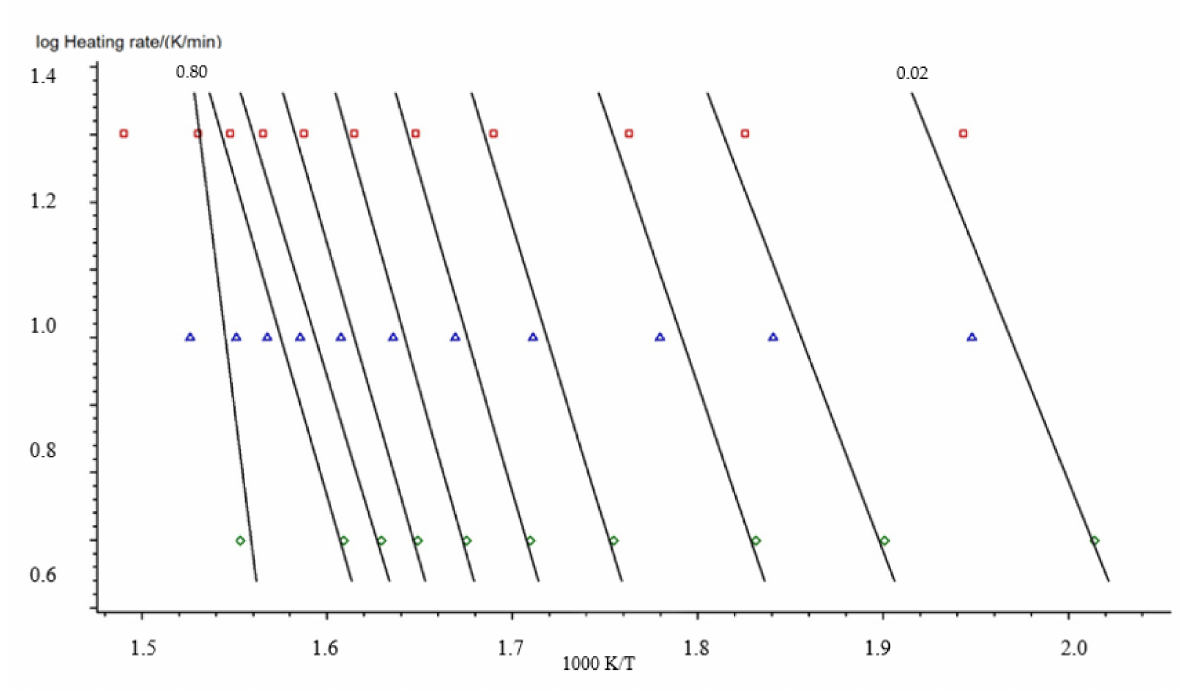
Figure 11. Plot of logarithm dx/dt as a function of the reciprocal of temperature for the Ozawa–Flynn–Wall method for pine wood. Symbols are representing, heating rates, Red: 20K/min, Blue: 10 K/min and Green: 5